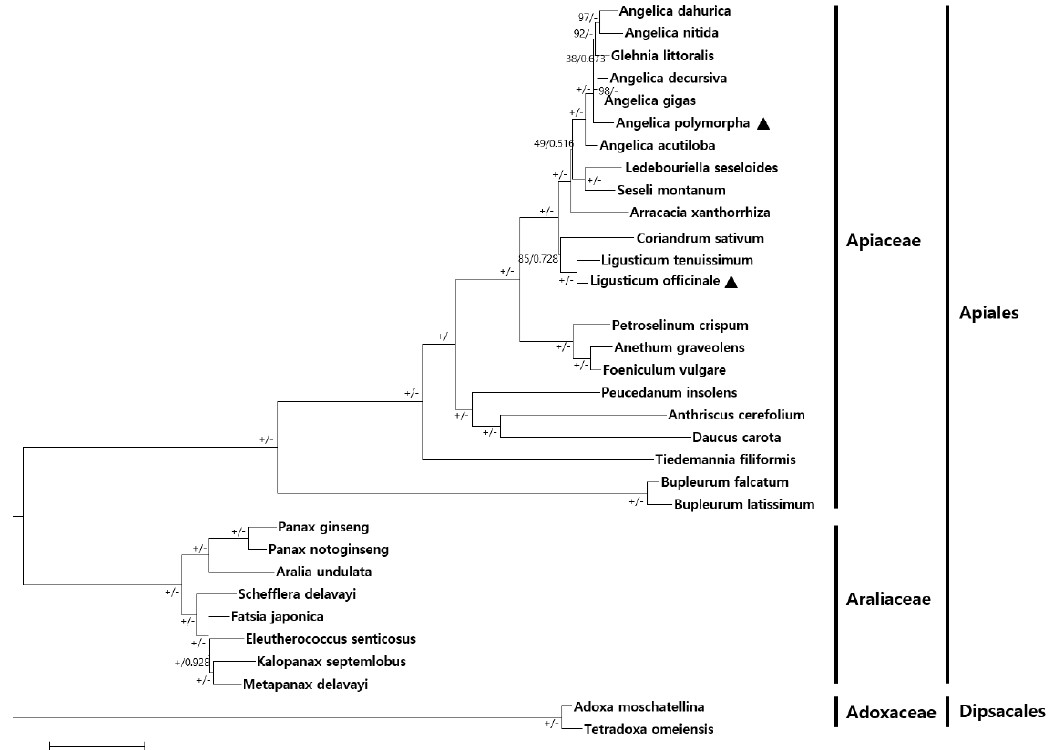
Figure 5. Phylogenetic tree showing the relationship of A. polymorpha with 31 species based on 52 protein-coding genes using maximum likelihood (ML) and Bayesian inference (BI) posterior probabilities. The ML topology is indicated with ML bootstrap support values and BI posterior probabilities at each node. The ‘+’ sign indicates ML bootstrap values of 100%, and the ‘–’ sign indicates BI posterior probabilities of 1.0. Black triangles represent the CP genomes of A. polymorpha and L. officinale examined in this study.